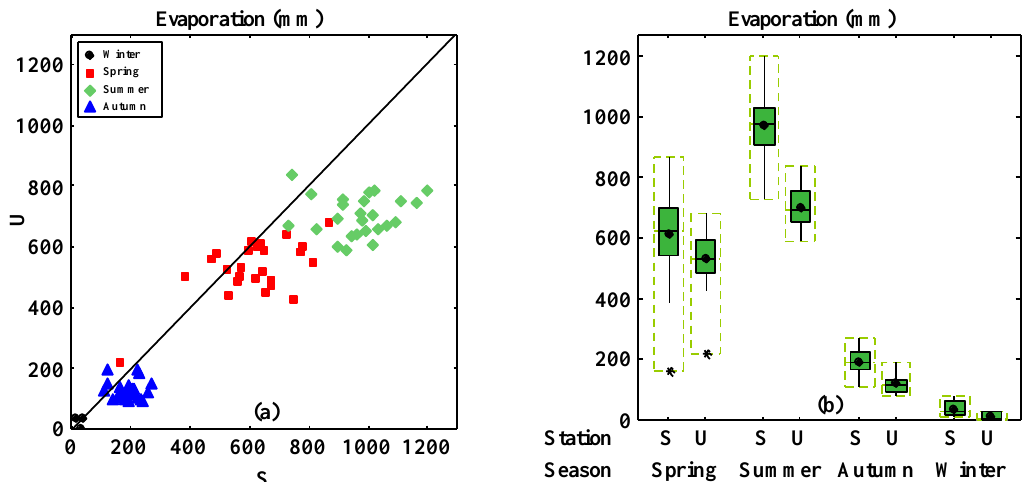
Figure 8. Seasonal pattern in evaporation. ( a ) Scatterplot of evaporation in the different seasons at Urmia station (U) and Saqez station. ( b ) The corresponding boxplot.